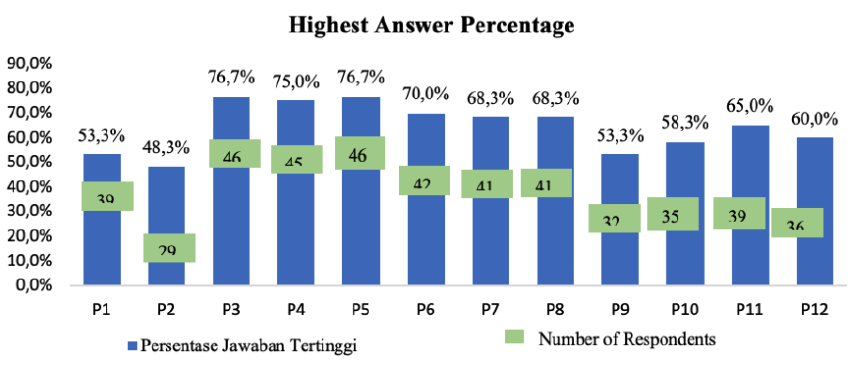
Figure 4: Percentage of Programs Required by Graduate